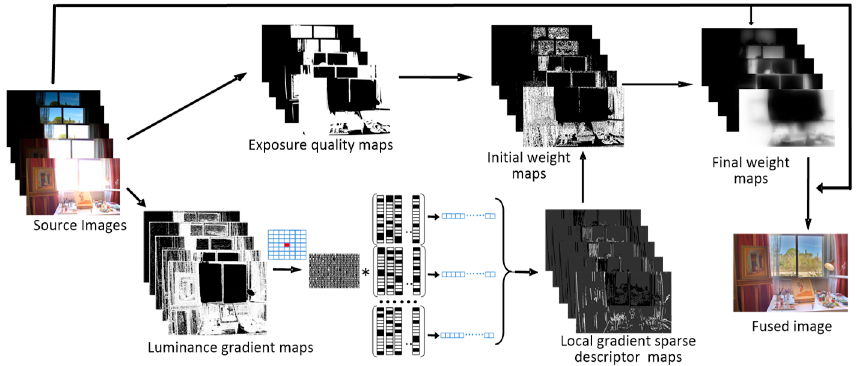
Figure 3. Schematic diagram of the proposed multi-exposure.